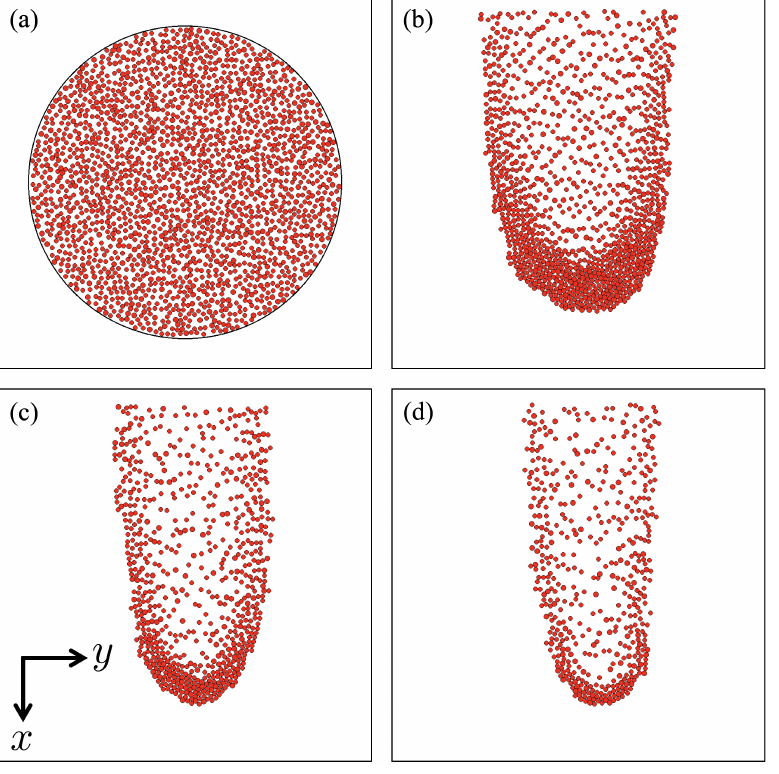
Figure 4. Time evolution of single head formation with a p = 5 mm in the circular setup: ( a ) ˜ t = 0, ( b ) ˜ t = 7.96, ( c ) ˜ t = 19.5, and ( d ) ˜ t =